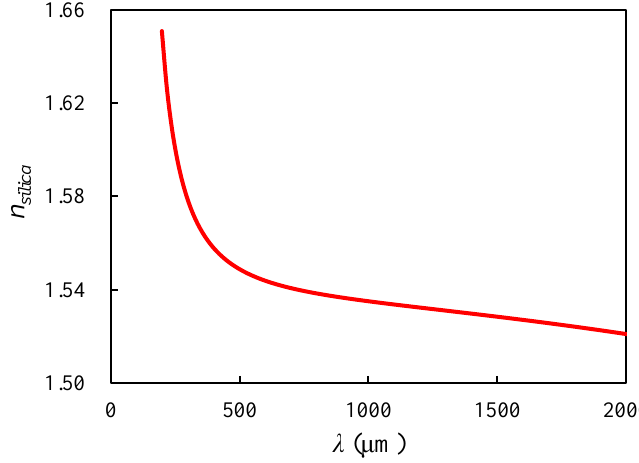
Figure 3. Evolution of n silica with respect to the